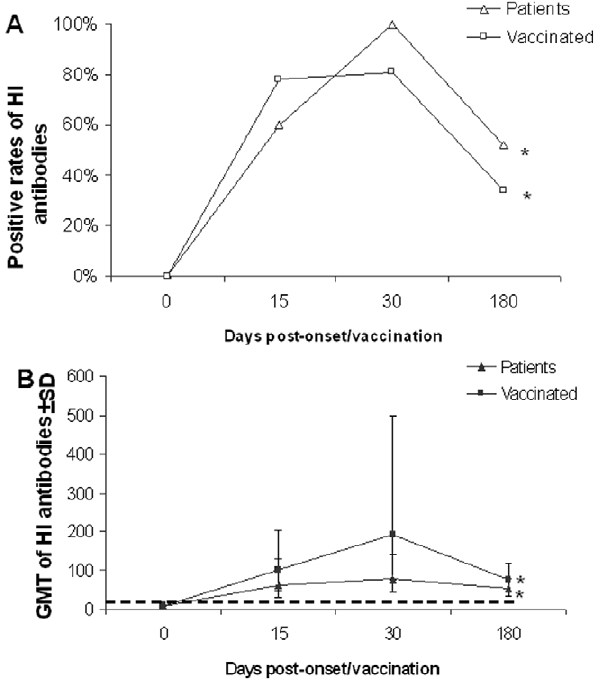
Figure 1. HI antibody dynamics in infected patients and vaccinated people. Note: Detection limitation (HI titer , 20) is indicated by the dotted line. Error bar indicates 6 standard deviation (SD) from different individual study subjects. * indicates significant differences ( P , 0.01) between results of day 30 and day 180.